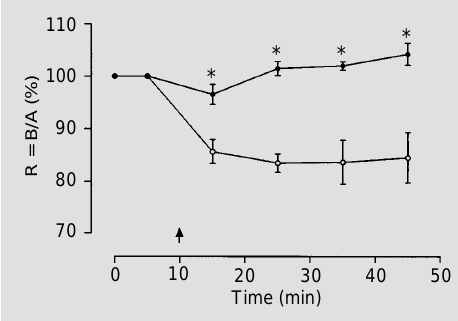
Figure 3 - Antagonism by methylene blue (7.2 µg/kg) of tetanic fade induced by nitric oxide (NO) (1.5 mg/kg) in cat anterior tibial muscle preparations. On the ordinate, the R ratio (B/A) is expressed as a percentage of that obtained 5 min after injection of drug-free saline (open circles) or saline containing methylene blue (filled circles). NO was injected at time = 10 min (arrow). Drugs were adminis- tered through the middle genicular artery. Points repre- sent the mean (± SEM) of 4 to 6 experiments. *P<0.05 compared to % of the R ratio obtained with the use of 1.5 mg/kg NO in the absence of